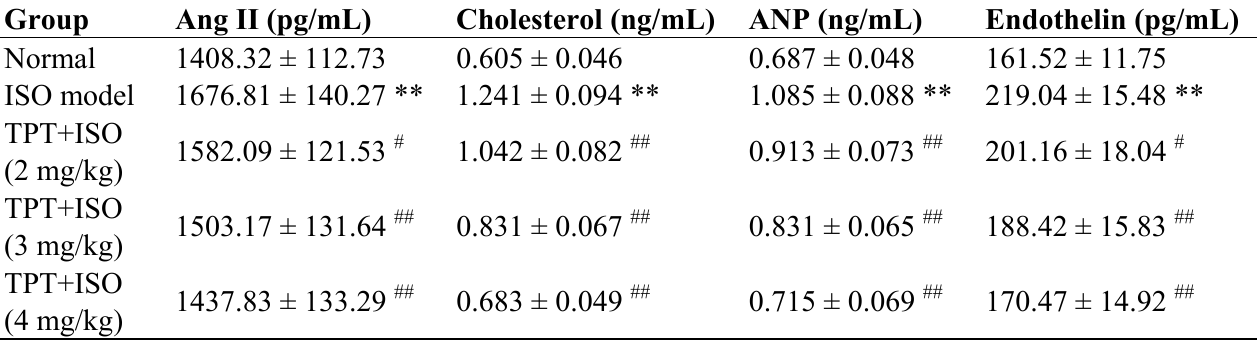
Table 3. Effect of TPT on serum Ang II, Cholesterol, ANP and Endothelin levels in all groups of rats.